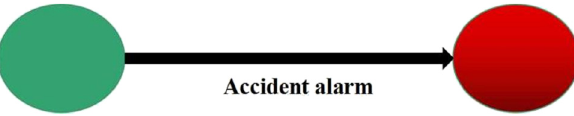
Figure 3: Accident warning light turns red.